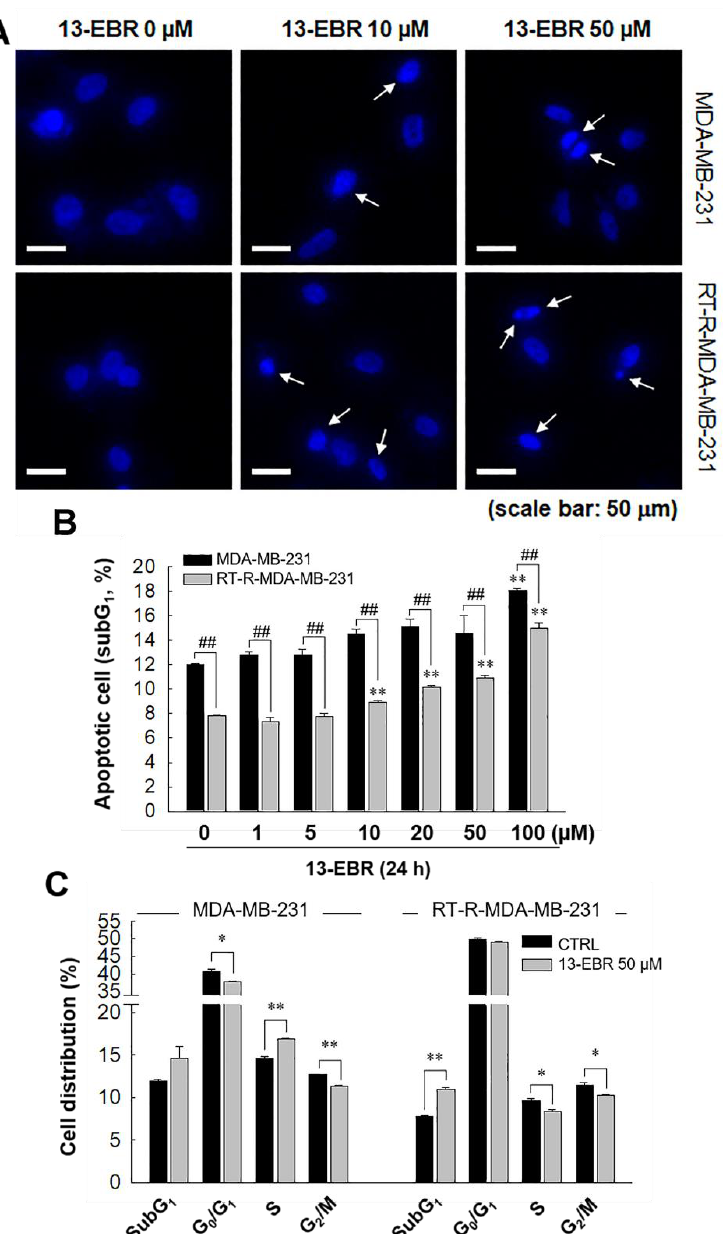
Figure 3. Induction of apoptotic cell death in MDA-MB-231 and RT-R MDA-MB-231 cells with 13-EBR through the intrinsic pathway. ( A ) Both cell lines were seeded on a cover slip that was mounted onto a self-designed perfusion chamber and then stimulated with 13-EBR at the indicated doses for 24 h. The fragmented DNA was observed, as described in Section 4. White arrows represent the fragmented DNA. ( B ) Both breast cancer cell lines were treated with 13-EBR at the indicated doses for 24 h, and then apoptotic cells were identified by analyzing the sub-gap 1 (subG 1 ) phase using a fluorescence-activated cell sorting (FACS) system, as described in Section 4. ( C ) Both cell lines were treated or were not treated with 13-EBR at 50 µ M for 24 h, and then the cell distribution in the cell cycle was determined using the FACS system. The values represent the mean ± SEM of three independent experiments; ** p < 0.01, * p < 0.05 compared to the control; ## P < 0.01 compared to the MDA-MB-231